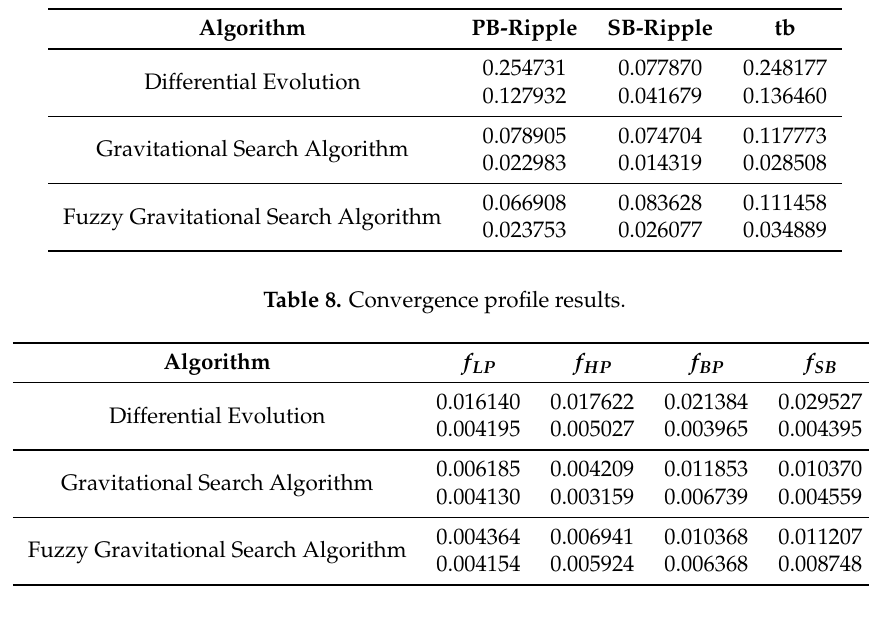
Table 7. Pass band ripple, stop band ripple and transition band of SB filters.